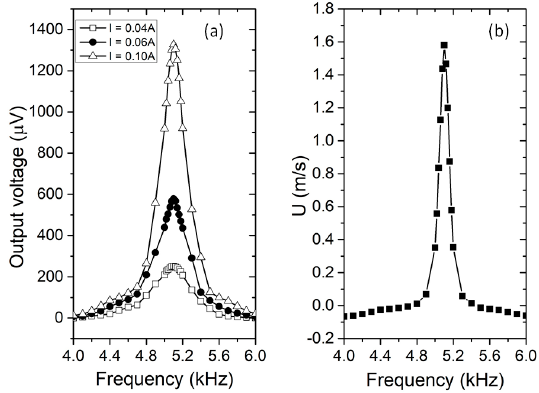
Figure 7. Frequency response of the device. The actuating voltage on PZT is 8 V. The tungsten hotwire was heated using different currents and the measured flow velocity was converted from hotwire output voltage ( I = 0.1 A).